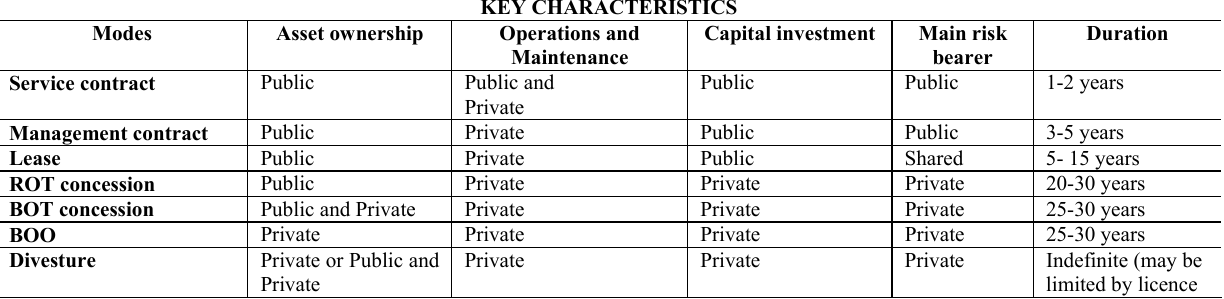
Table 2: Allocation of key responsibilities under the various modes of PPPS KEY